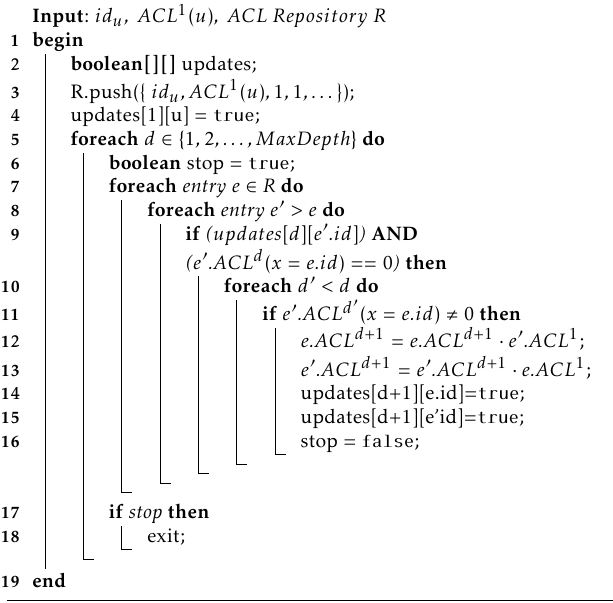
Algorithm 5.1 : ACL propagation